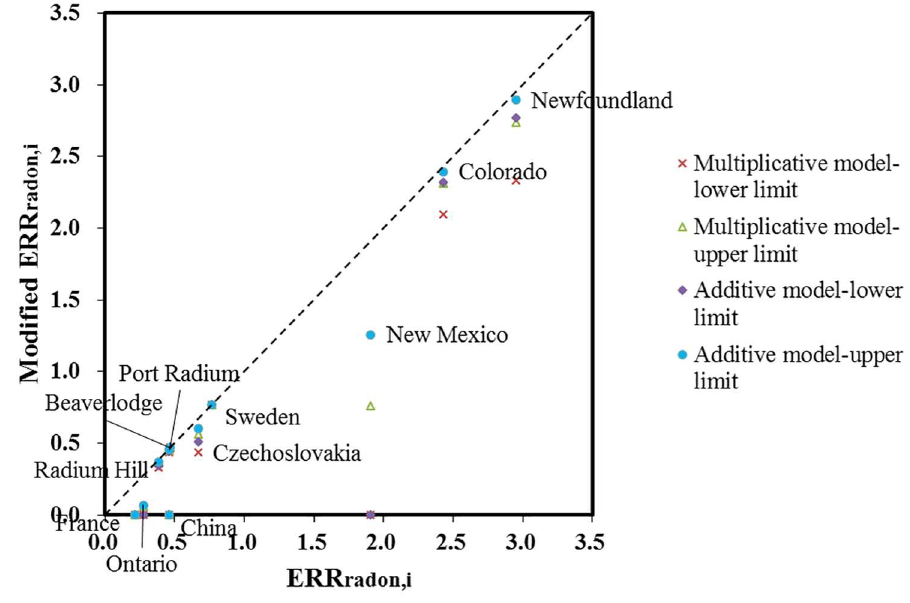
Fig 1. Scatter plot of the modified ERR radon , i versus the original ERR radon , i in each cohort.